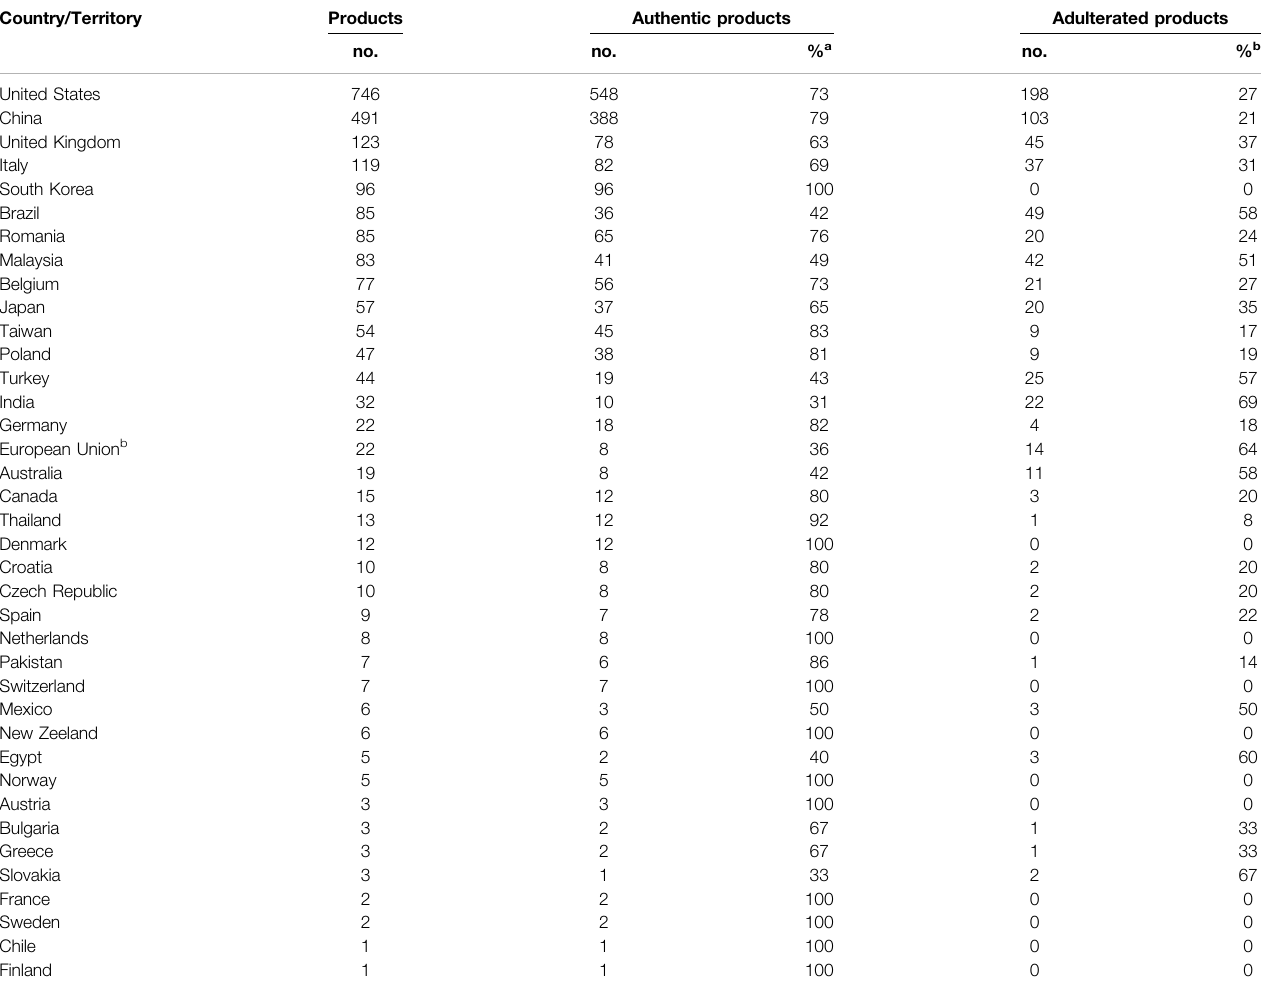
TABLE 2 | The distribution and authenticity of the chemically authenticated commercial herbal products at national level.